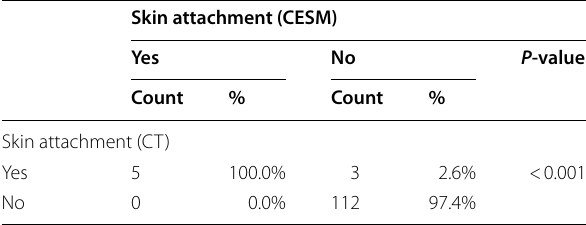
Table 5 Association between CESM and MDCT assessment of skin attachment